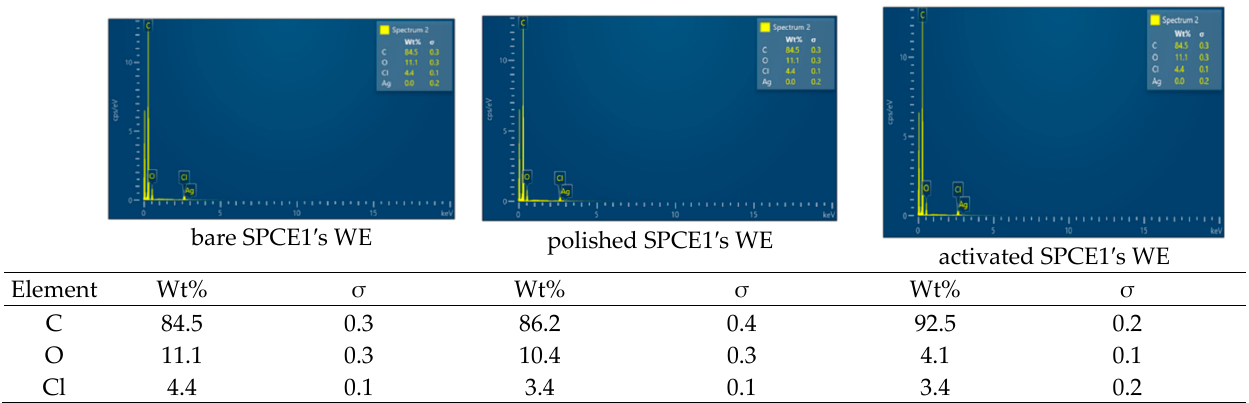
Figure 4. EDS signals (5 keV) and weight percentage of the elements obtained analyzing the SPCE1 WE surface before the polishing procedure, after the polishing procedure, and after the electrochemical activation.